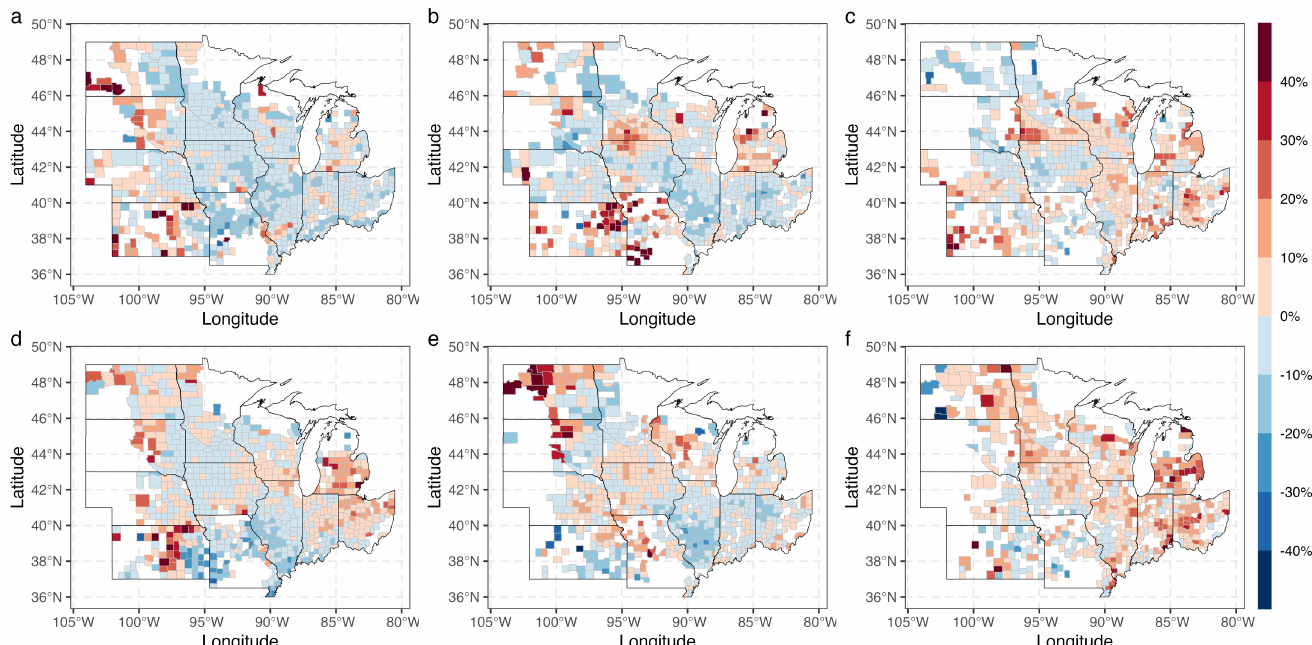
Figure 6. The percentage error of crop yield forecasts by county. Yield of ( a – c ) corn and ( d – f ) soybean was predicted in ( a , d ) 2017, ( b , e ) 2018 and ( c , f ) 2019 using the LAI time series from the day of year of 89 to